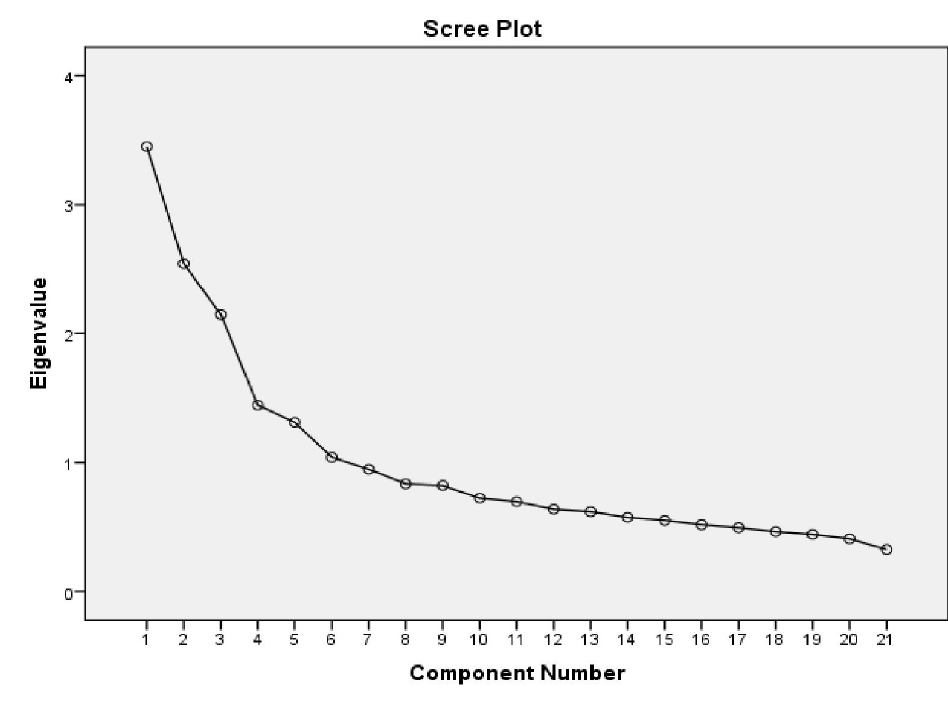
Fig. 1. The results of Scree plot